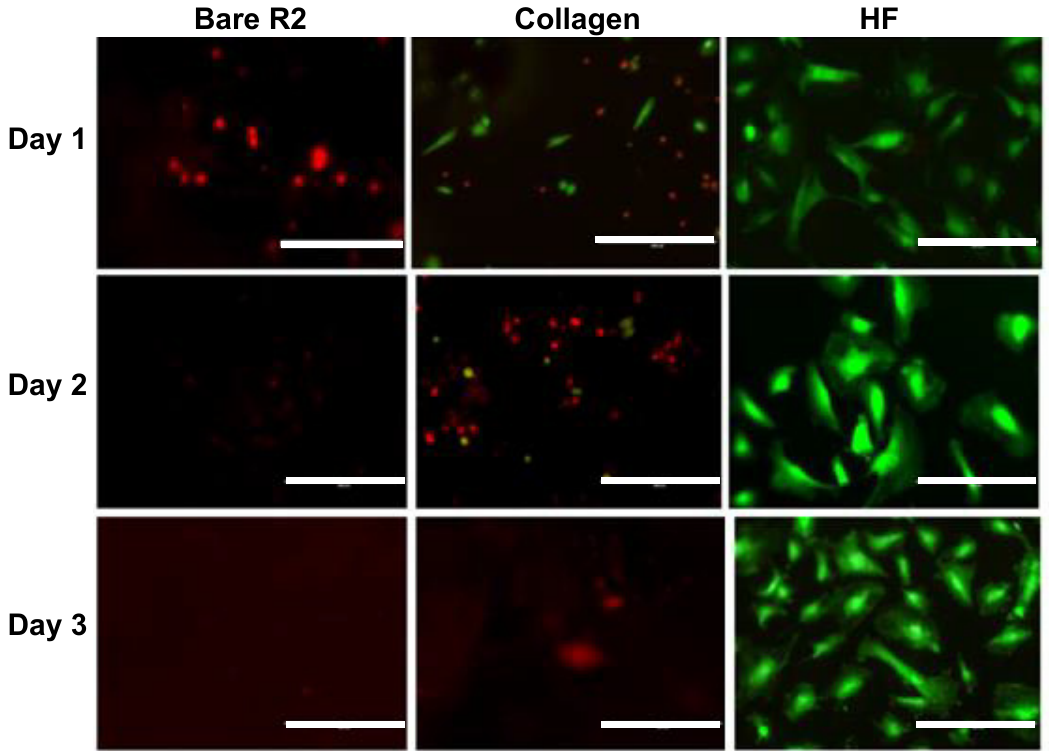
Figure 8. Endothelial cells cultured on bare R2, collagen coated R2 and HF treated R2 alloys from day 1 to day 3. (Scale bar: 10